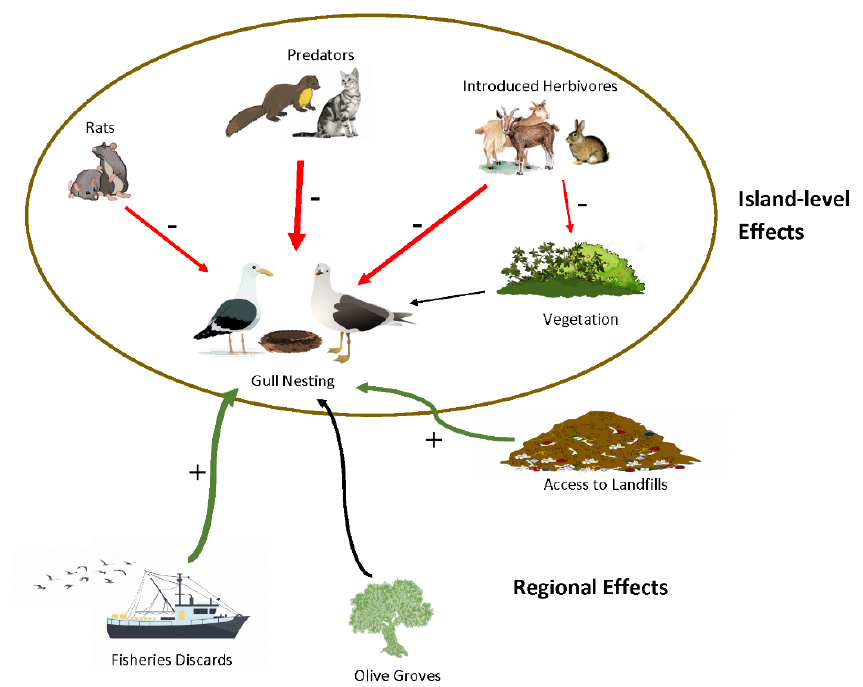
Figure 5. Conceptual diagram depicting functional interactions for a typical Larus michahellis colony in the Aegean Sea Region, including island-level and regional relationships with the potential to affect colony size and density. Red arrows represent expected negative effects, while green arrows suggest positive impacts.